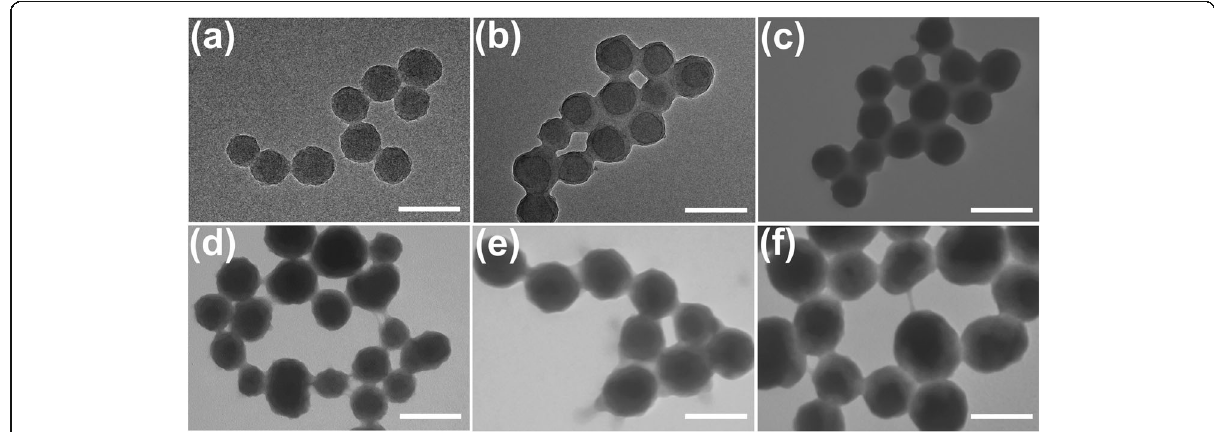
Fig. 2 TEM images of PDA@PMAA nanoparticles (scale bar, 200 nm). a PDA. b PDA@PMAA-0.5. c PDA@PMAA-1. d PDA@PMAA-2. e